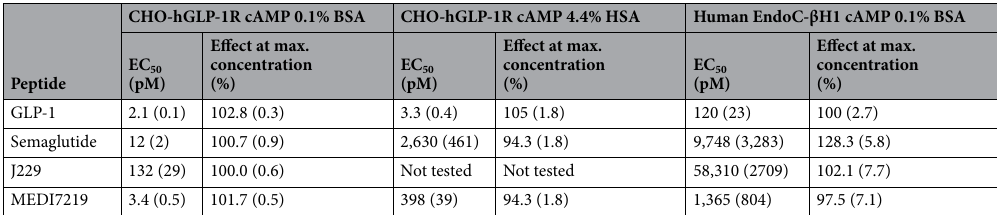
Table 1. cAMP accumulation assay in CHO cells stably expressing human GLP-1R (with 0.1% BSA or 4.4% HSA) or in EndoC-βH1 human pancreatic β-cells (with 0.1% BSA). Values are presented as geometric mean (standard error of mean). EC 50 calculated from n ≥ 3 independent experiments. BSA, bovine serum albumin; cAMP, cyclic adenosine monophosphate; CHO-hGLP-1R, Chinese hamster ovary cell line expressing human glucagon-like peptide 1 receptor; EC 50 , half maximal effective concentration; GLP-1, glucagon-like peptide 1; GLP-1R, glucagon-like peptide 1 receptor; HSA, human serum albumin.